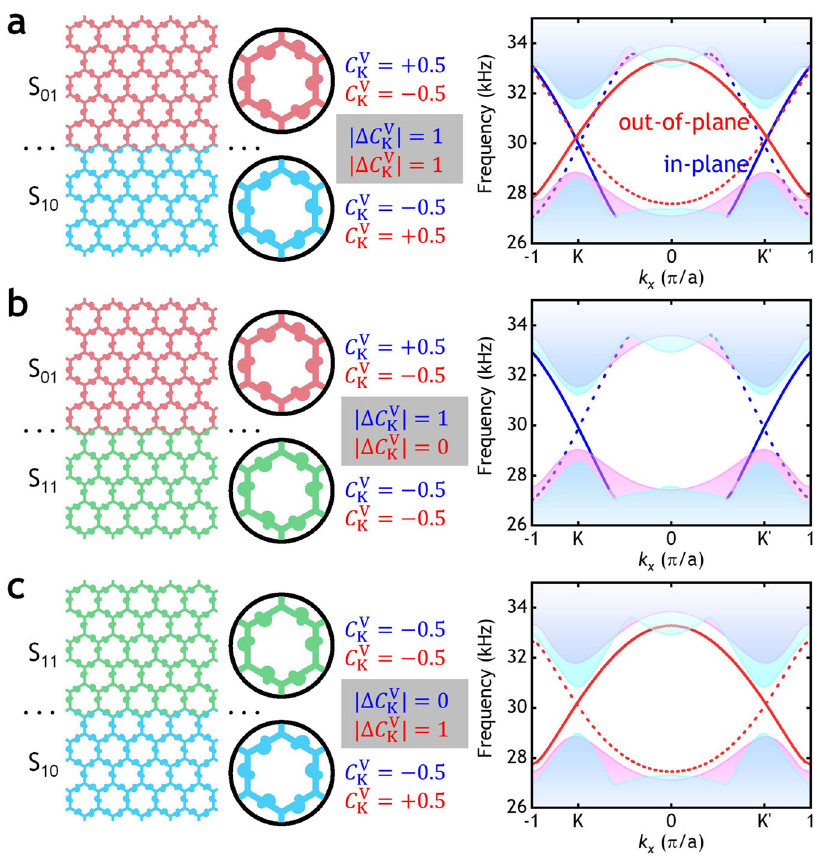
Fig. 5 Linearly polarized and topologically protected edge state between two phononic crystals. a , b , c Schematics of ( a ) domain wall S 01 S 10, ( b ) domain wall S 01 S 11 , and ( c ) domain wall S 11 S 10 , and their band diagrams. Ideal valley Chern numbers and their difference for in-plane polarized (IPP) [out-of-plane polarized (OPP)] wave are written in blue[red] color. The solid blue(red) line in the band diagram corresponds to the IPP(OPP) edge state of the domain wall, and the light-blue(light-red) area corresponds to the bulk band of the phononic crystals. The dotted blue(red) line in the diagram corresponds to IPP(OPP) edge state for the domain wall S 10 S 01 for ( a ), S 11 S 01 for ( b ), and S 10 S 11 for ( c ). Linear polarization of each edge states are presented in Supplementary Fig.